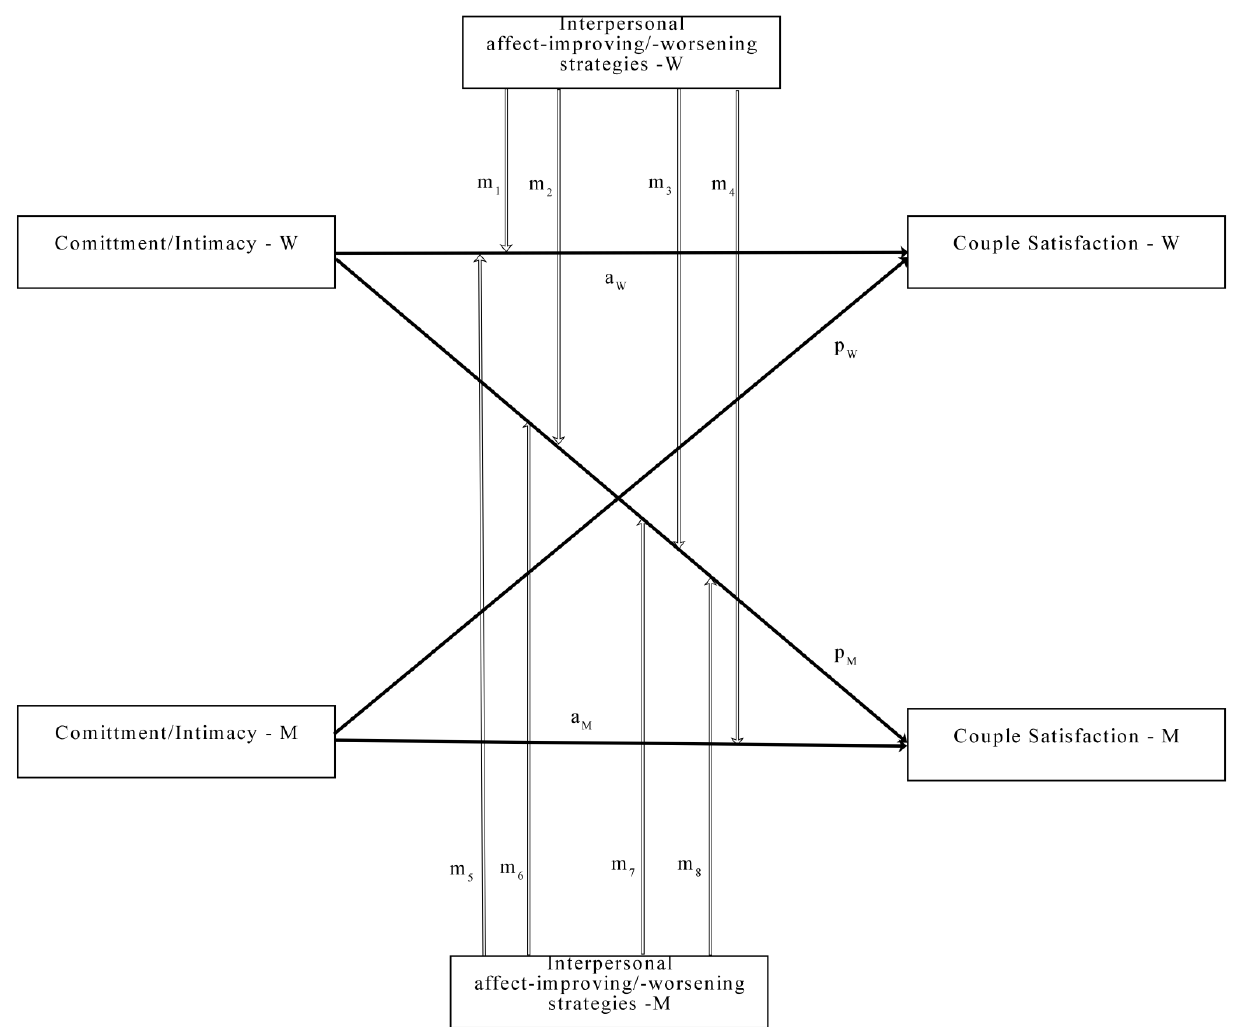
Figure 1. Conceptual moderated actor–partner interdependence model. Commitment/Intimacy— independent variable; Couple satisfaction—dependent variable; Interpersonal affect-improving/ affect-worsening strategies—moderator. a = actor effect; p = partner effect; m = moderator effect; W = women; M = men.